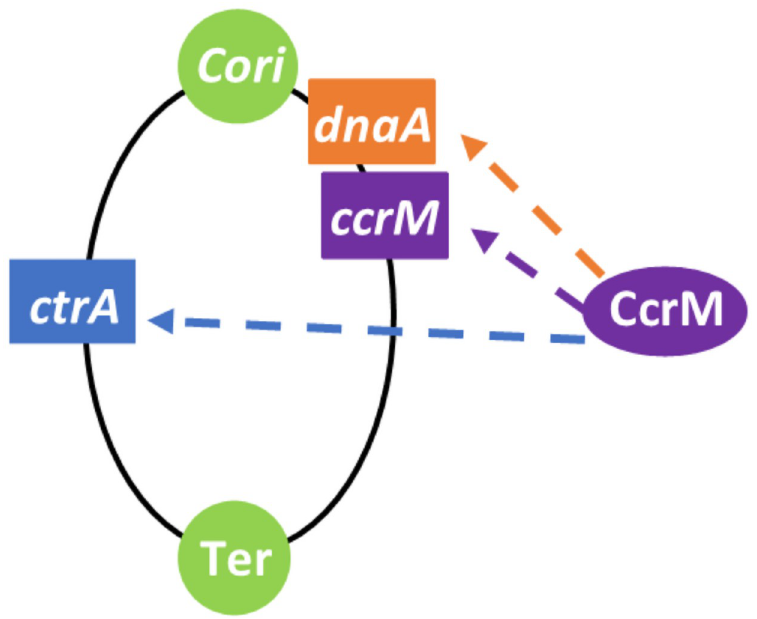
Fig 2. Methylation site locations of different genes on C. crescentus chromosome. The elliptical curve represents the DNA fork in replication. Cori is the origin of DNA replication and Ter is the termination site. The CcrM methylation site is located upstream of the dnaA , ccrM and ctrA genes, represented as